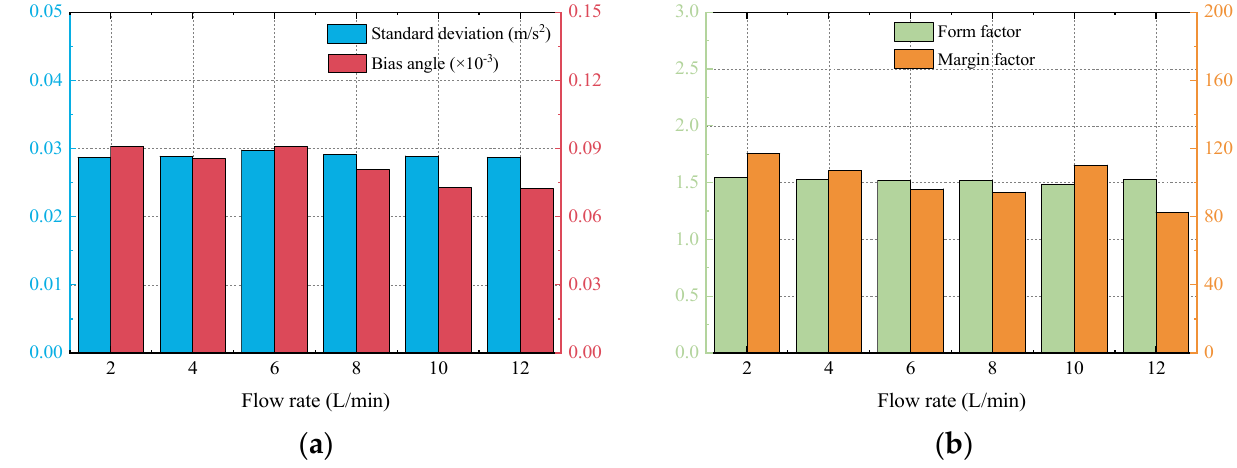
Figure 17. Effect of the flow on time domain eigenvalues. ( a ) Standard deviation and bias angle, ( b ) form factor and margin factor.